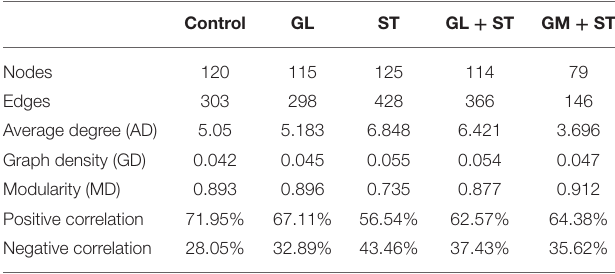
TABLE 3 | Topological properties of co-occurrence